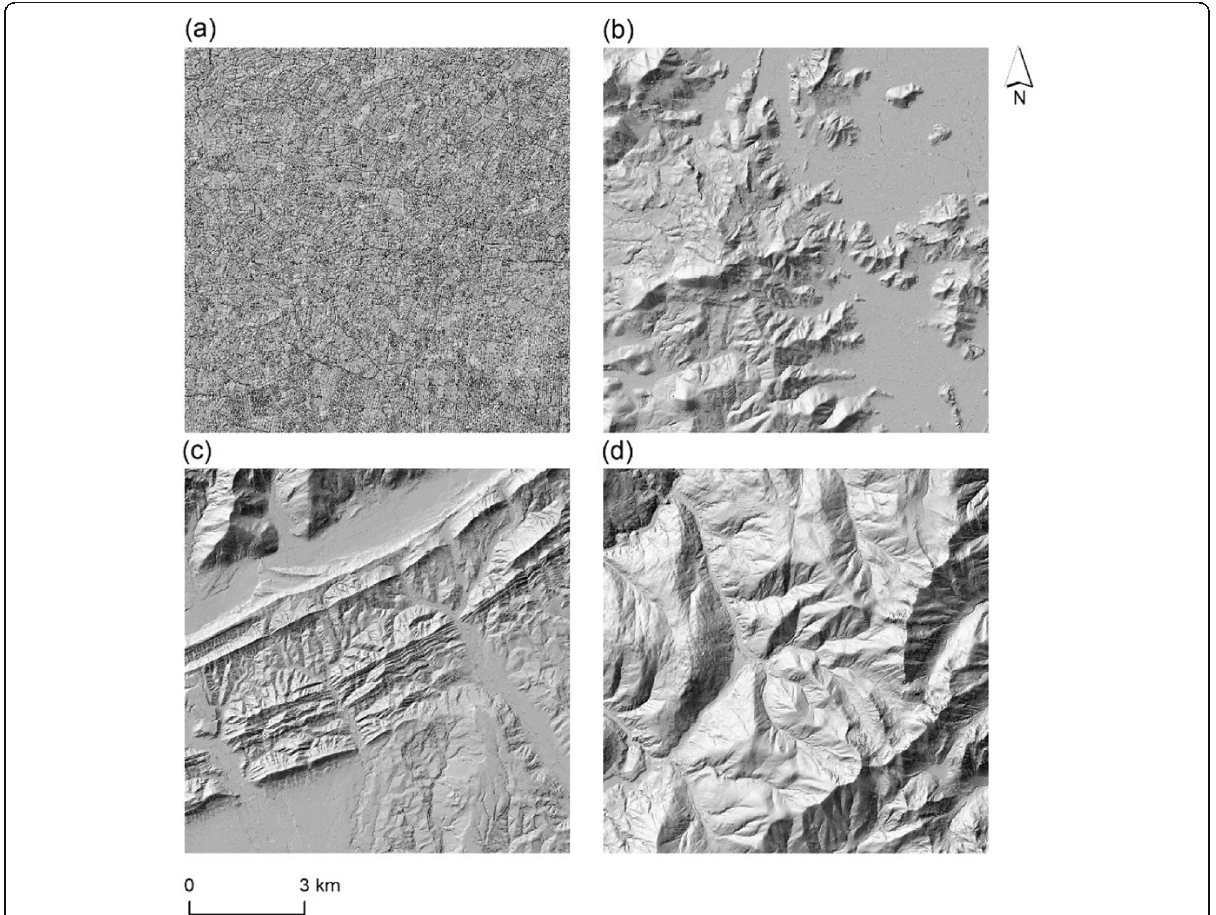
Fig. 3 LiDAR DTMs of the four study areas: a floodplain, b plain to hilly, c hilly, d